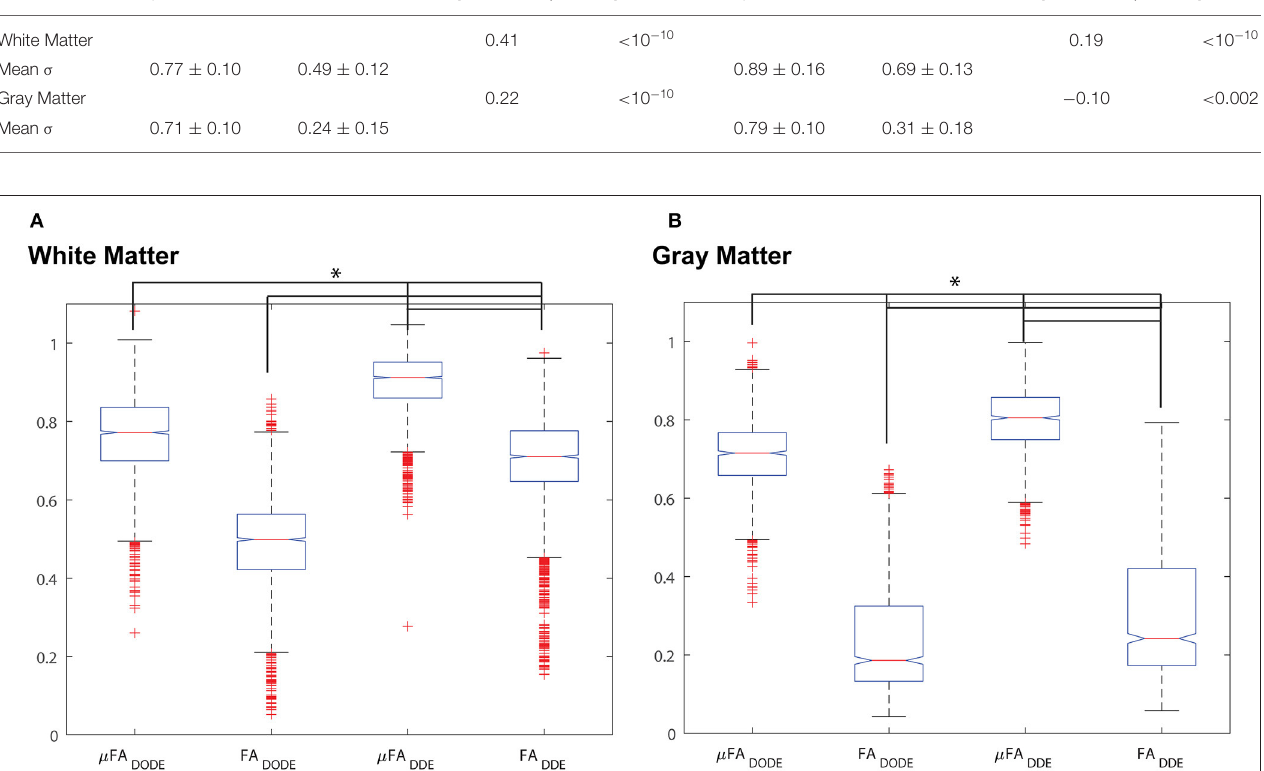
FIGURE 5 | Box-and-whisker plots of the different metrics. (A) White matter analysis. (B) Gray matter analysis. * p < 10 − 12 between all pairs from ANOVA with Bonferroni post-hoc comparison and corrected for multiple comparisons.